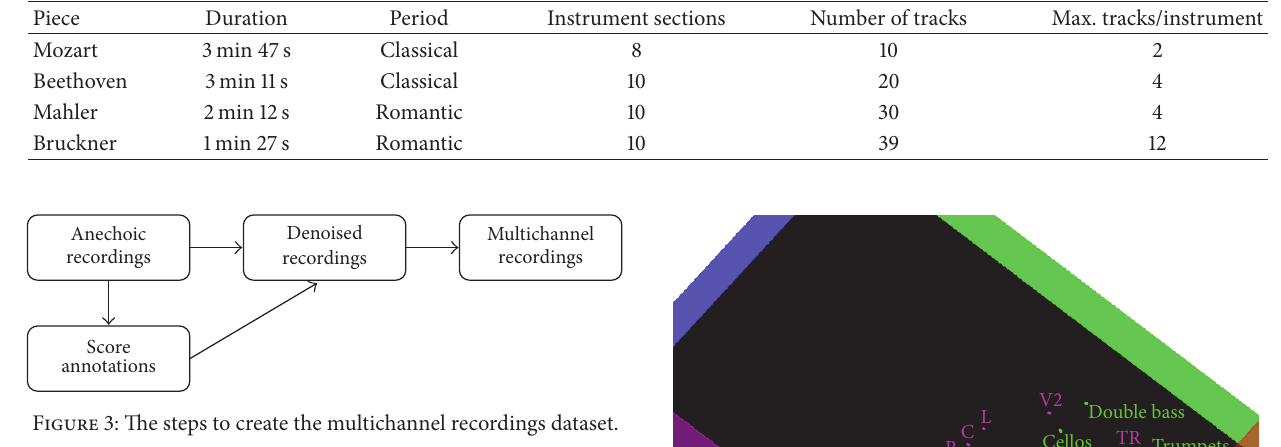
Table 1: Anechoic dataset [30] characteristics.